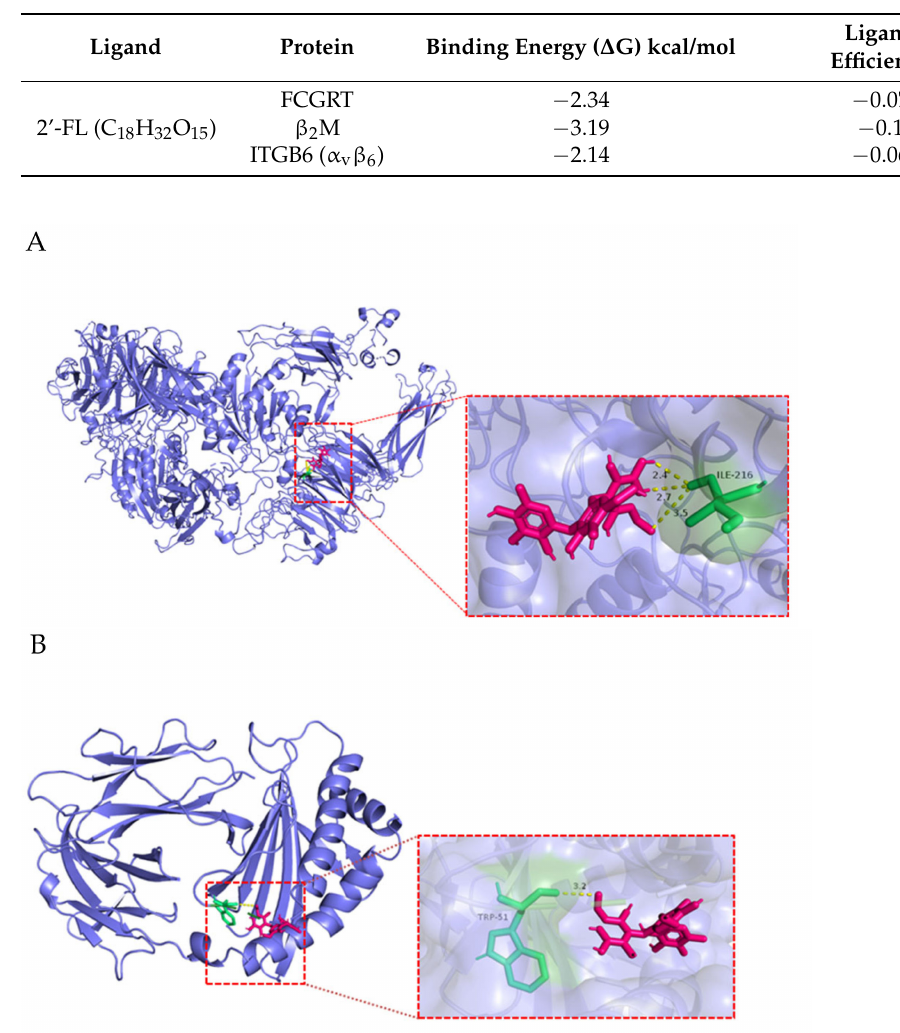
Table 1. Molecular docking analysis of several compounds against 2’-FL.